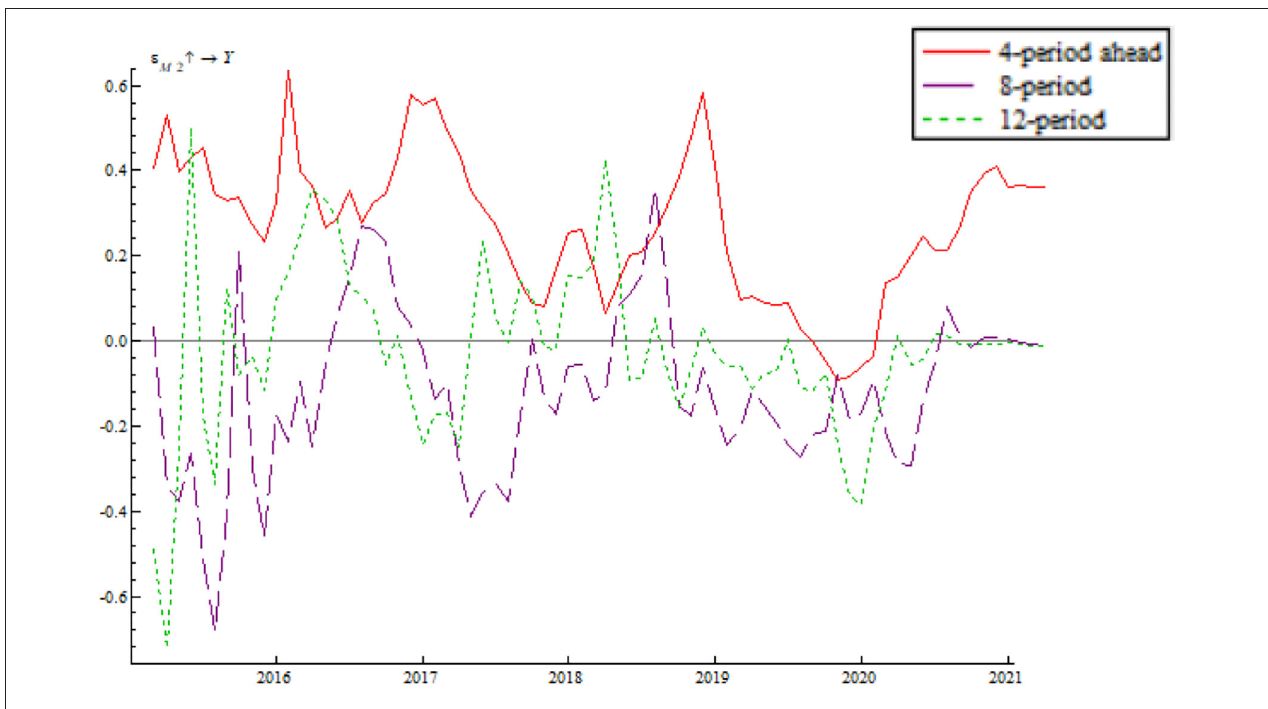
FIGURE 8 | Shock of the quantitative monetary policy instrument on output gap.